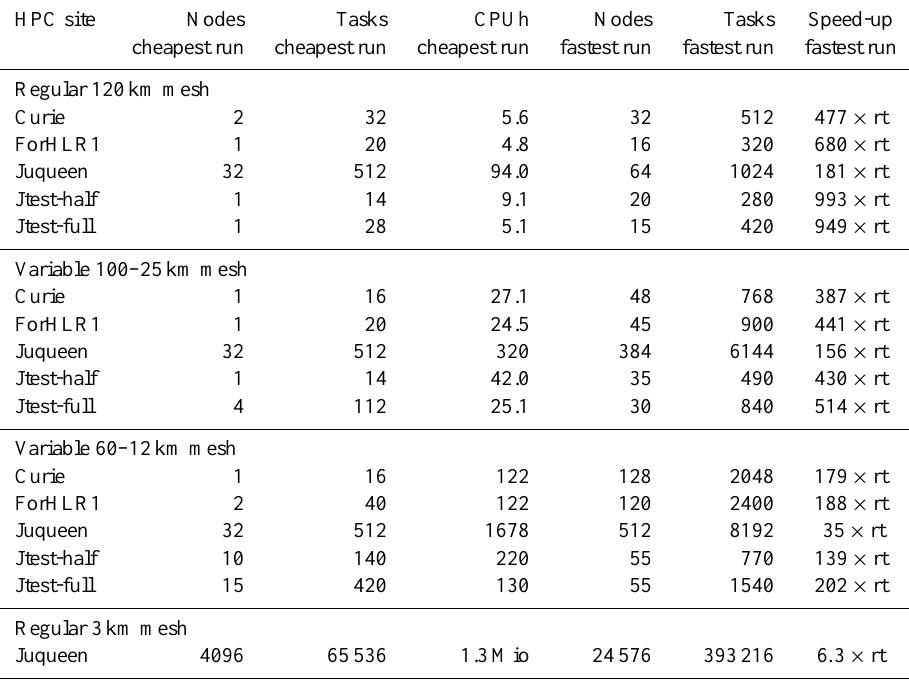
Table H2. Summary of the scaling tests: cheapest and fastest model run configurations for a 24h model integration with disk I/O enabled (rt is real